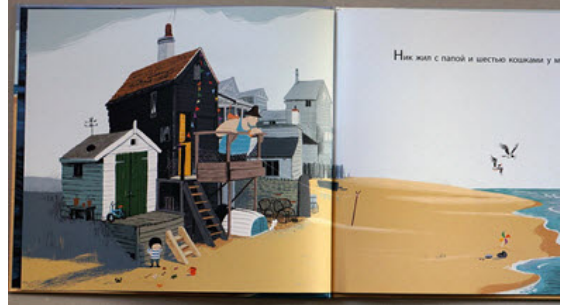
Figure 3. The illustration for the book “The Day, When the Whale Returned”. The author and artist is B. Davis.